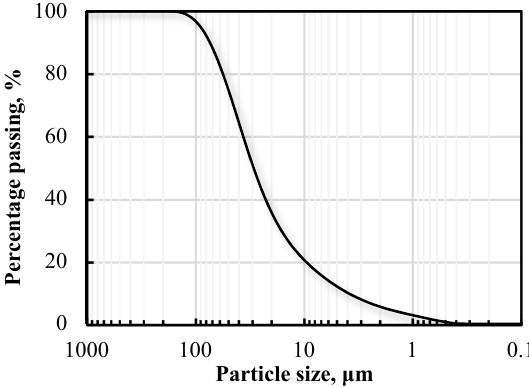
Figure 1. Grain-size distribution curve.